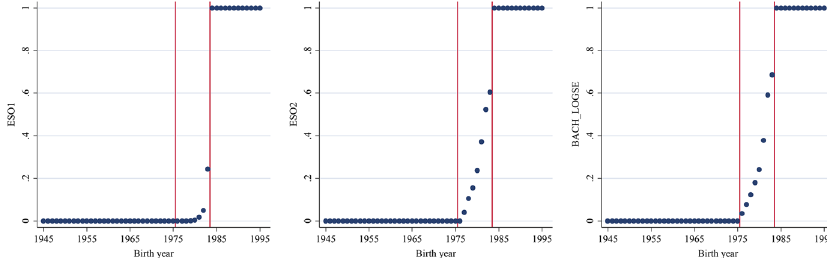
Fig. 2 Variables of implementation of the LOGSE by year of birth Wecalculatethe ESO1